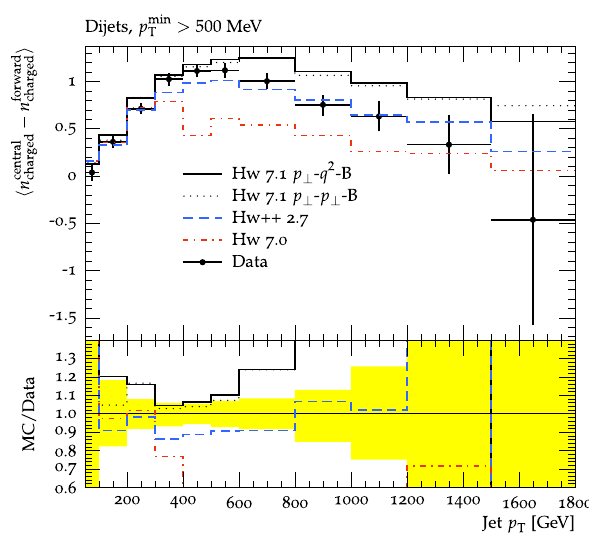
Fig. 13 The difference between the average number of particles in central and forward jets compared with data from the ATLAS experi- ment